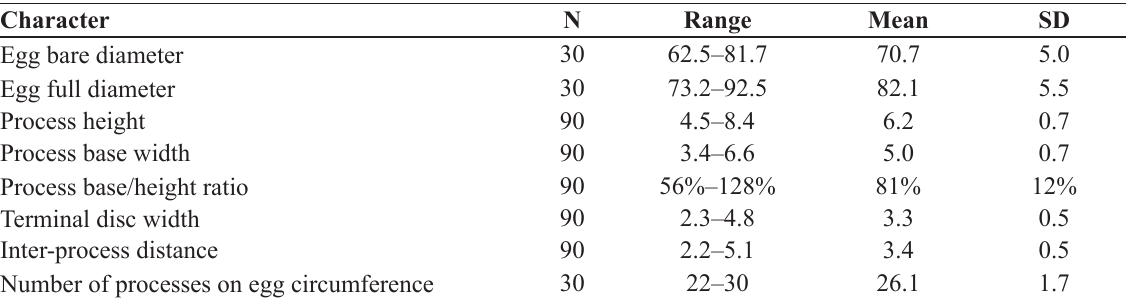
Table 3. Measurements (in μm) of selected morphological structures of the eggs of Macrobiotus noongaris sp. nov. mounted in Hoyer’s medium (N = number of eggs/structures measured; Range = the smallest and the largest structure among all measured specimens; SD = standard